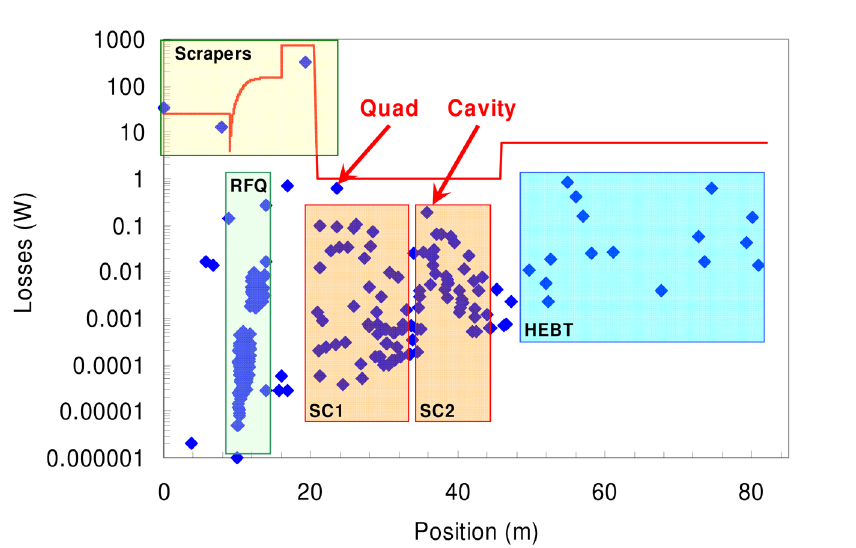
FIG. 20. (Color) Average loss repartition along the structure. The most critical components are pointed with red